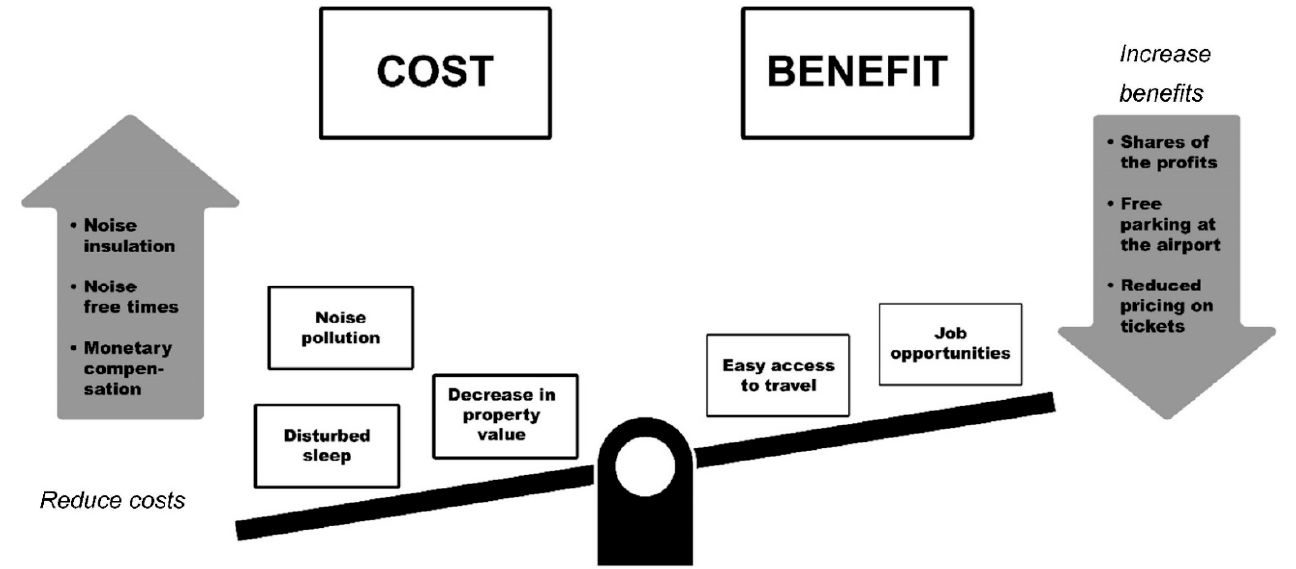
Figure 1. Illustration of balancing the individual cost–benefit ratio.